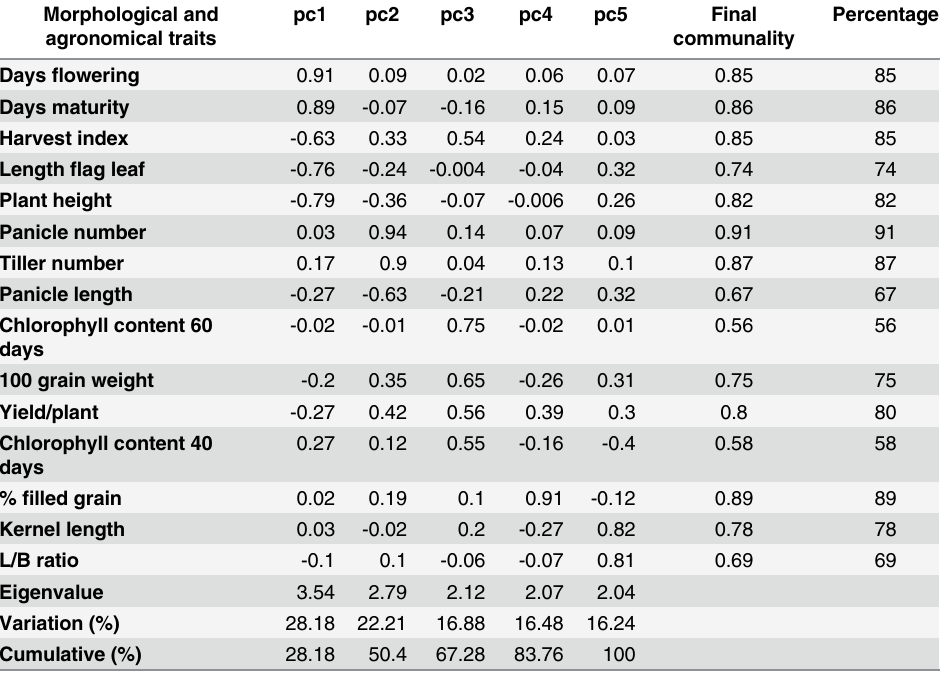
Fig 5. Principle component analysis (PCA) from morphological and agronomic data.